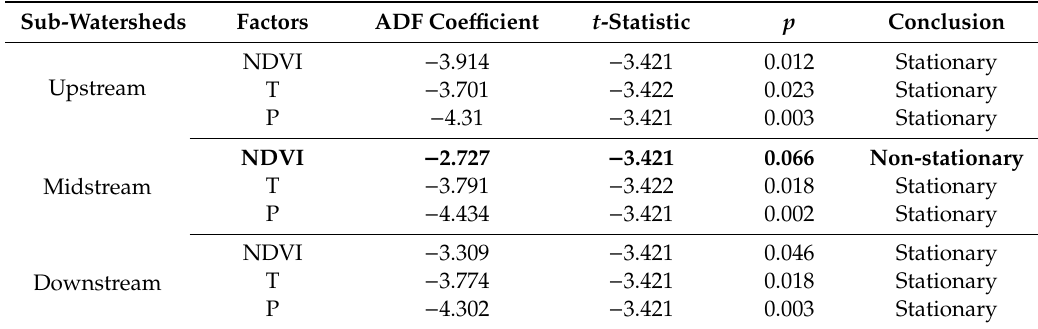
Table 3. Results of Augmented Dickey–Fuller Test (ADF) test for vegetation and climatic sequence.